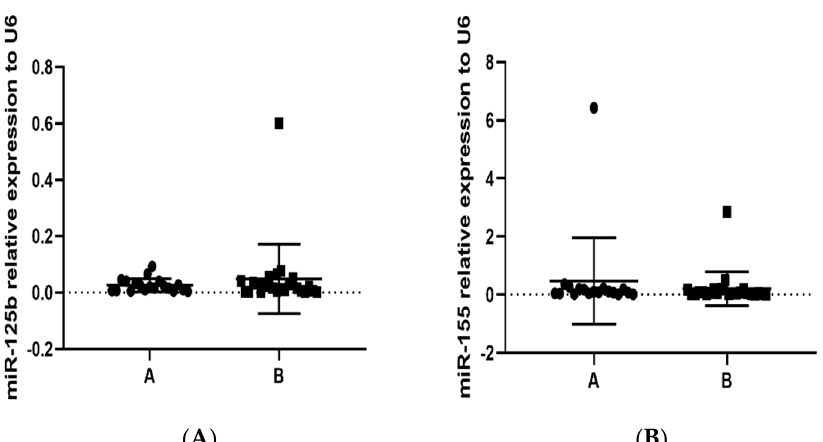
Figure 3. Determination by RT-qPCR of miR-125b and miR-155 relative expression in PBMCs in population (groups A and B) exposed to PAHs: ( A ) miR-125b, p = 0.2201; and ( B ) miR-155, p = 0.2227. Small nuclear RNA U6 was used for normalization.